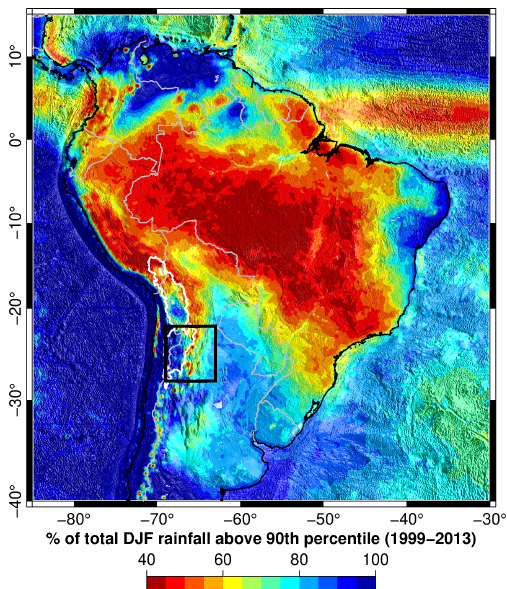
Figure 6. Percentage of 90th percentile rainfall contribution to total DJF rainfall (1999–2013) derived from TRMM3B42 data. Note the high contribution in the south–central Andes in our study region (black box).The central Andean Plateau is marked in white and gray lines indicate international borders.